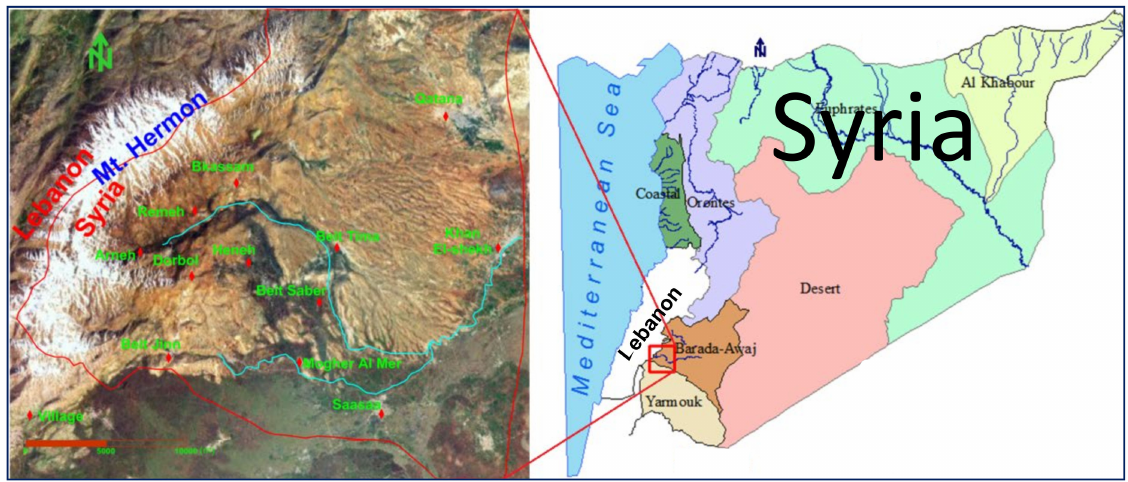
Figure 2. The location of the study area in Barada and Awj Basin ( left ) and the map of Syria ( right ), which is divided into seven hydrogeological basins, after the Ministry of Irrigation, Syria, unpublished